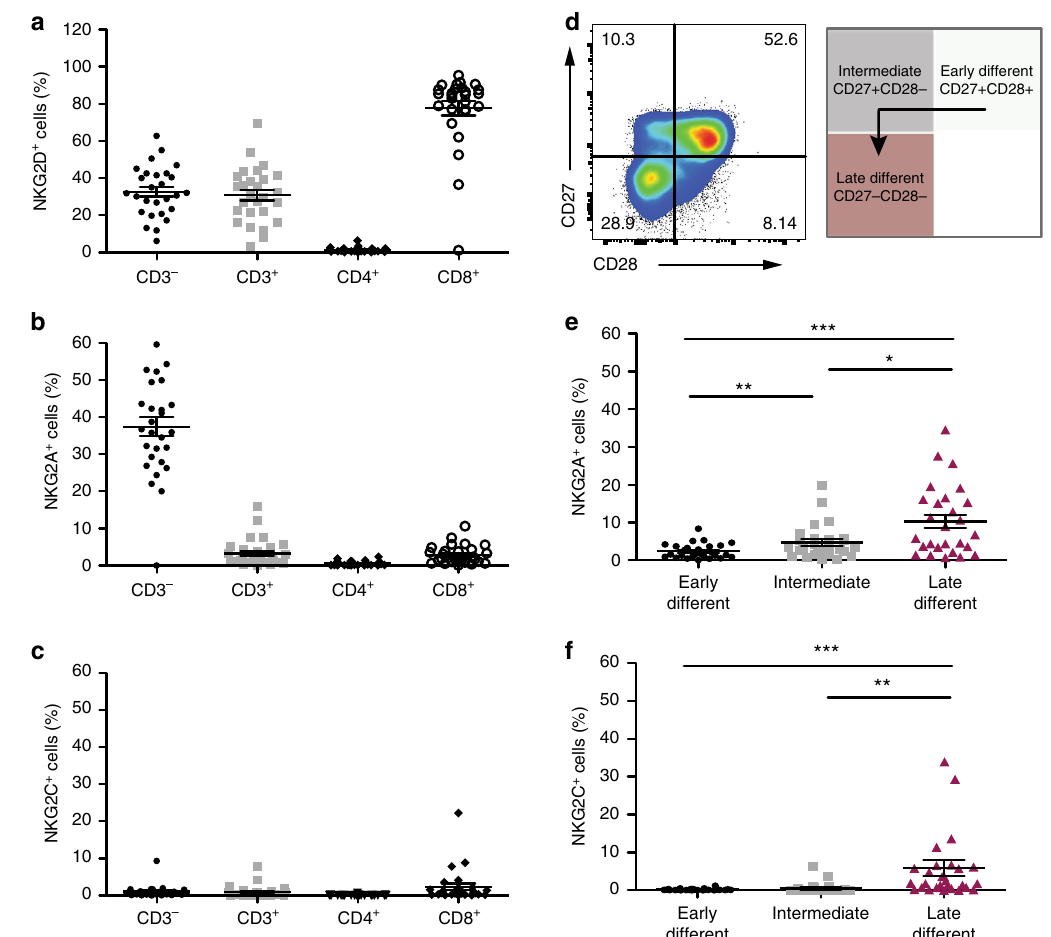
Fig. 3 MICA/B and HLA-E bind NKG2 receptors expressed on NK and CD8 + T cells. Distribution of ( a ) NKG2D + , ( b ) NKG2A + and ( c ) NKG2C + cells on the indicated subsets of human lymphocytes from blood of healthy volunteers ( n = 27; mean age 49.9; range, 27 – 83), analysed by fl ow cytometry. FACS sequential gating strategies represented in Supplementary Fig. 4. d Human CD8 + T cells were strati fi ed according to CD27 and CD28 expression in early- (CD27 + 28 + ), intermediate- (CD27 + 28 − ) and late-differentiated (CD27 − 28) cells, as represented in the fl ow-cytometry plot. e , f The summary data of the distribution of NKG2A + ( e ) and NKG2C + ( f ) cells within early-, intermediate- and late-differentiated CD8 + T cells gated as in ( d ) in the same donors ( n = 27; mean age 49.9; range, 27 – 83). Comparison between groups done with Friedman test with Dunn's correction for multiple comparisons in ( e ) and ( f ). The data presented as means ± SEM. * p < 0.05, ** p < 0.01, *** p < 0.001, **** p <